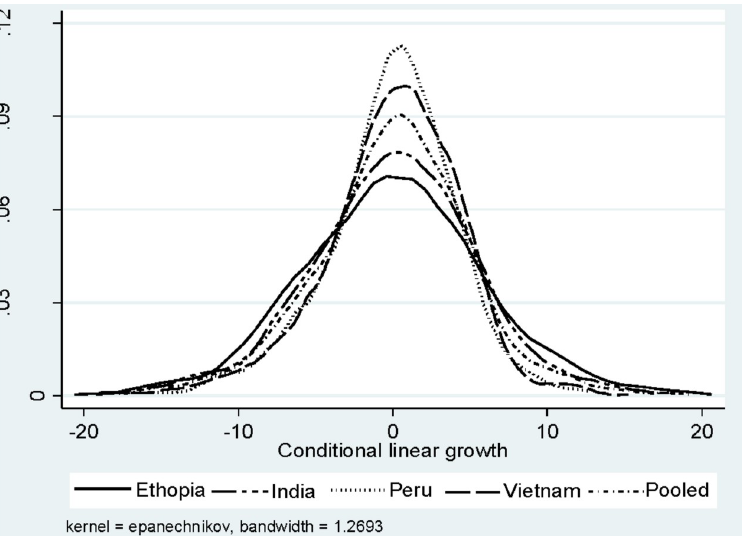
Fig 1. Kernel density of the conditional linear growth between 2002 & 2009, Ethiopia, India, Peru, Vietnam, and the pooled sample.